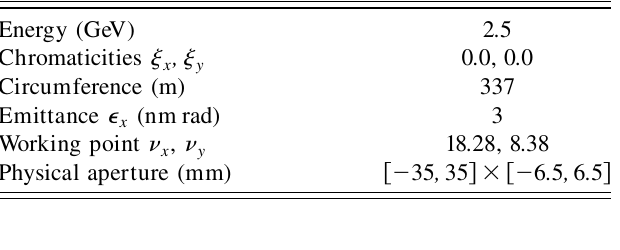
TABLE I. SOLEIL main parameters [15].